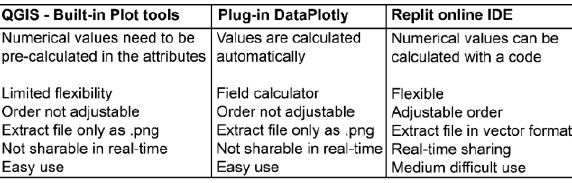
Table 3. Comparison between built-in plot tools of QGIS, plug- in DataPlotly, and online coding application Replit for making simple statistical analysis and graphically present results (source: D.